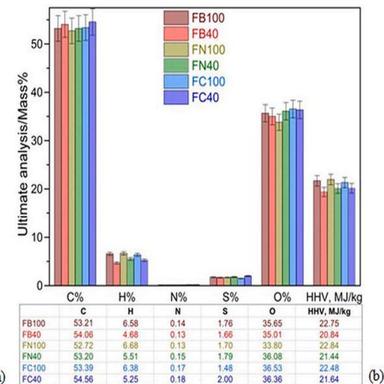
Proximate (a) and ultimate (b) analysis of silver fir biomass residues.